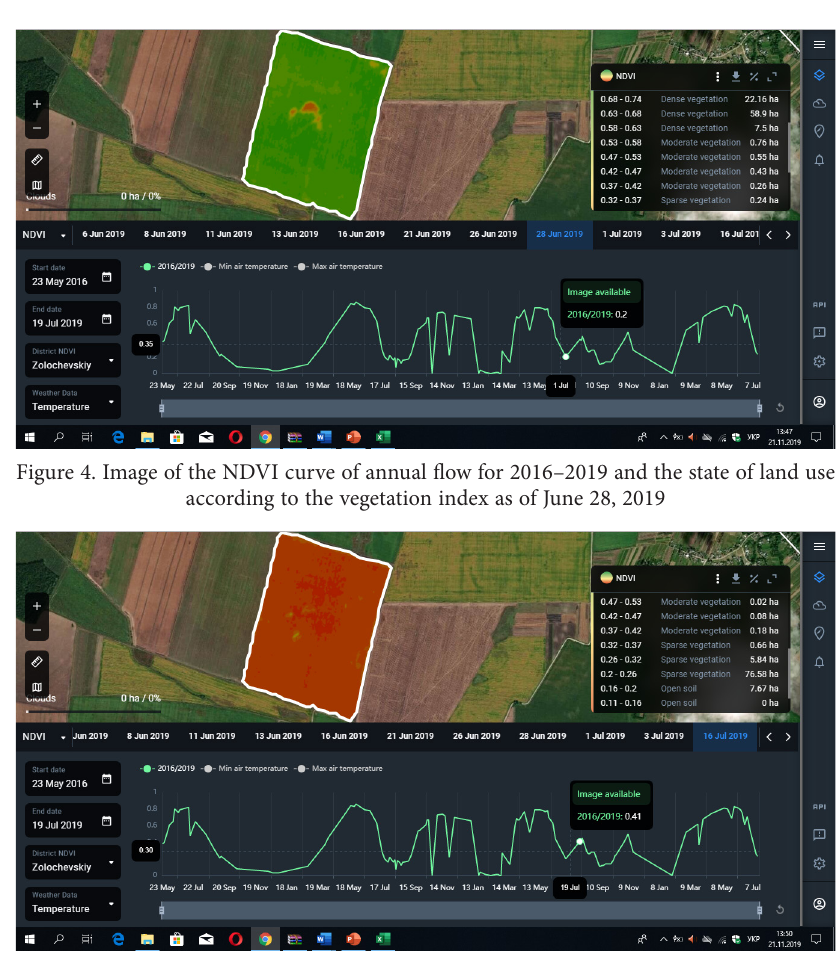
Figure 5. Image of the NDVI curve of annual flow for 2016–2019 and the state of land use according to the vegetation index as of July 16, 2019